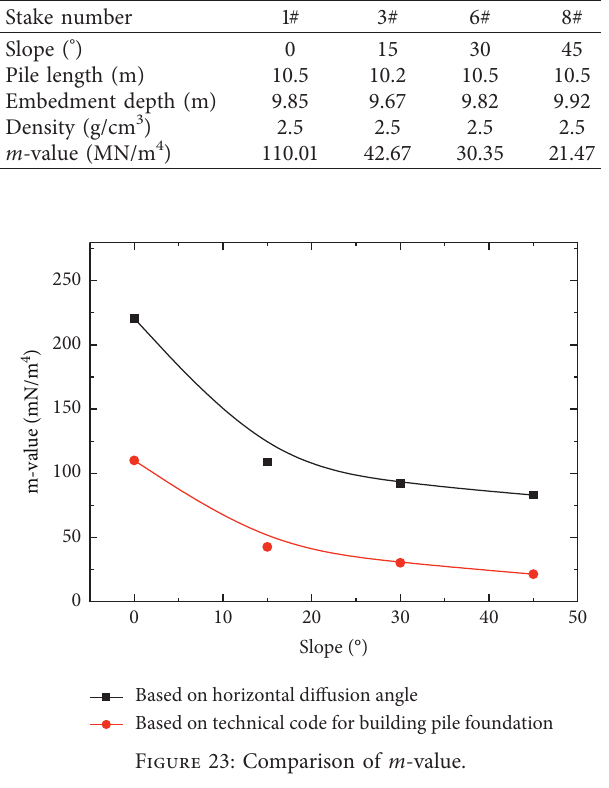
Table 10: m -value based on calculative width recommended by code.